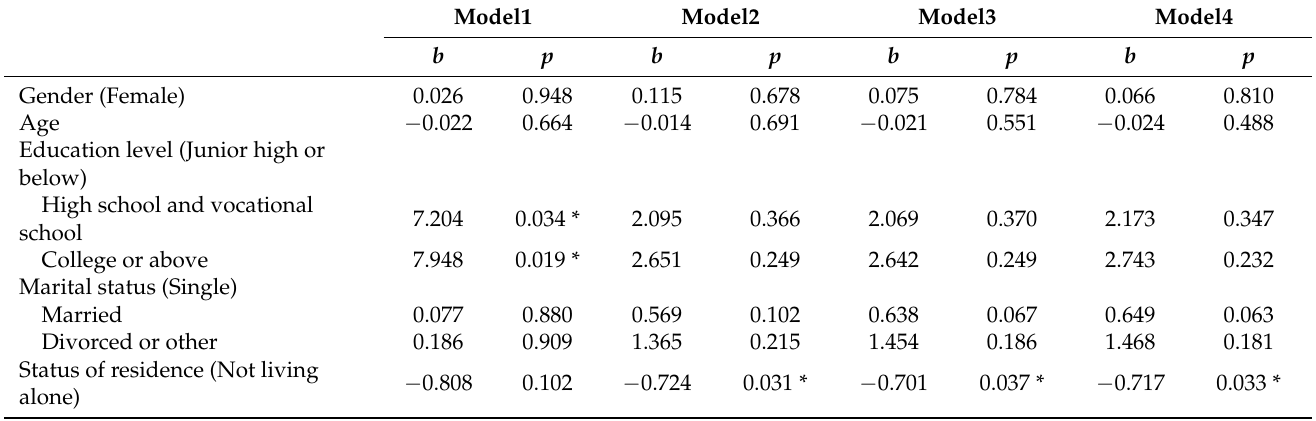
Table 4. Moderating effect of positive affect on the relationship between stress and anxiety in the total